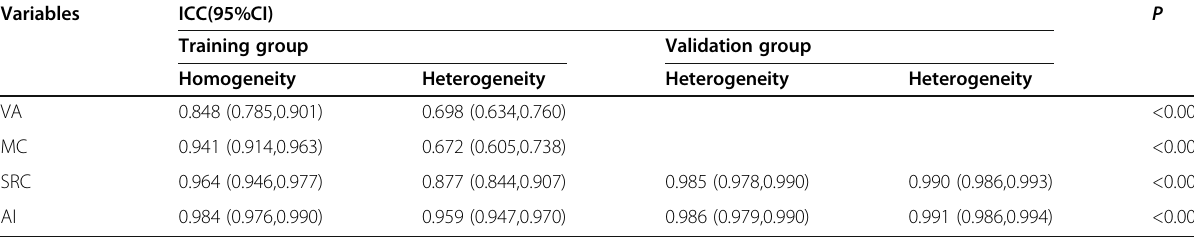
Table 4 The consistency between the training set and the validation set pathologists interpreting breast cancer Ki-67LI in the homogeneous and heterogeneous groups through SRC and AI